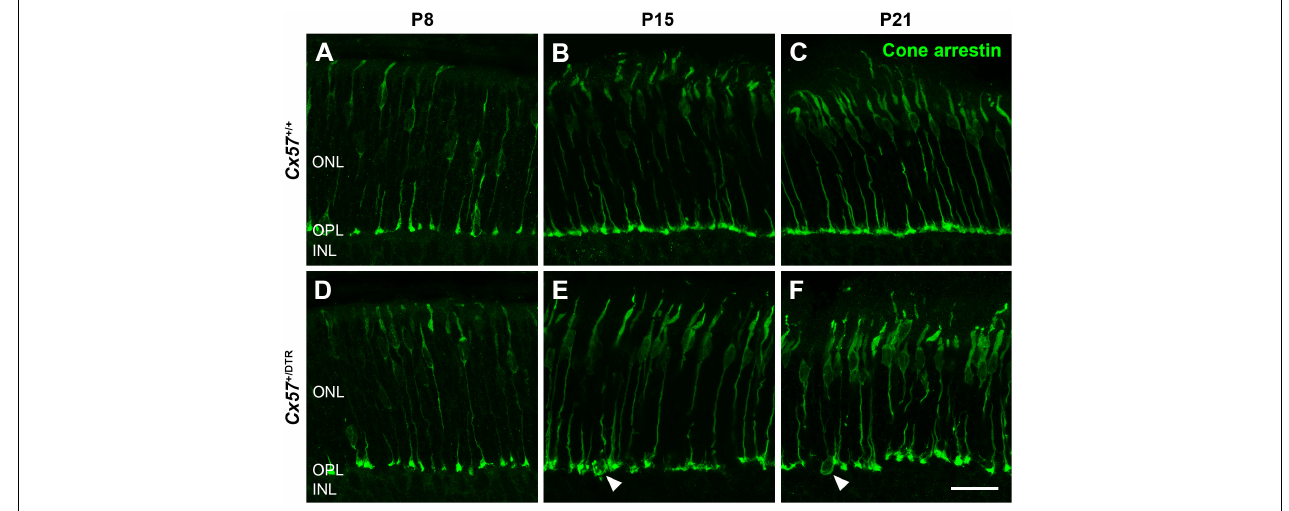
FIGURE 2 | Mislocalized cone somata following early postnatal horizontal cell ablation. (A–F) Retinae of Cx57 + / + and Cx57 + / DTR mice of different ages (P8, P15, and P21) were stained for cone arrestin, a marker for cone photoreceptors. In wild-type mice, cones displayed the classical morphology including outer segment, inner segment, cell body, axon and synaptic terminal (A–C) . Cone somata were scattered across the entire ONL at P8 (A) and positioned in the distal part of the ONL from P15 to P21 (B,C) . In Cx57 + / DTR mice, the cone morphology was initially comparable to that in wild-type mice (A,D) . From P15 onward, cone somata were partly mislocalized (arrowheads) (E,F) and cone terminals were irregularly distributed in the OPL (E,F) . Scale bar, 50 µ m.